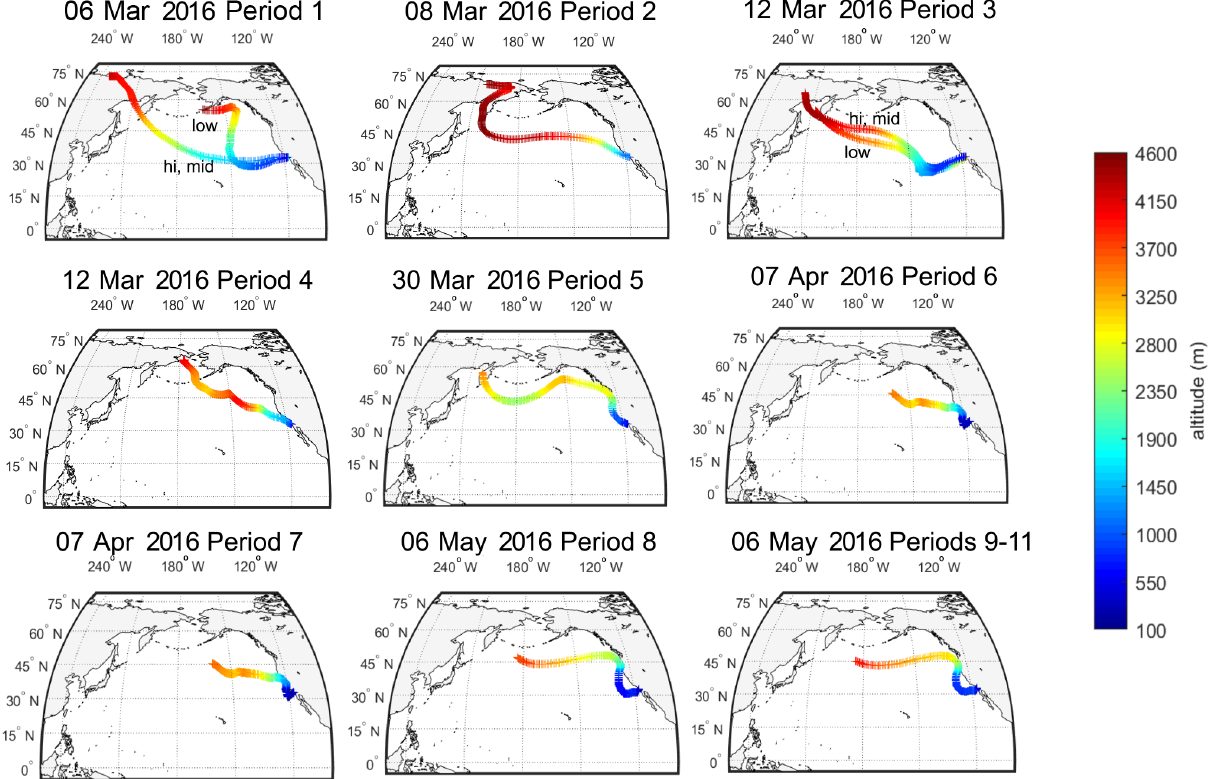
Figure 2. The 10d back trajectories from cloud base, mid-cloud and cloud top during 11 precipitation sampling periods at the SIO pier (32.8662 ◦ N, 117.2544 ◦ W). FLEXPART back trajectories were used to estimate potential source regions of INPs to the clouds during precipitation events. Shown are the particle centroids of back trajectories from three release altitudes within each cloud (see Table S2 for details on altitude selection criteria). If trajectories across the three selected release altitudes differed, they are labeled “hi” for cloud top, “mid” for halfway between base and top, and “low” for cloud bottom. Origins of particles in the 10d simulation are shown to range from 4000m over Russia to 2500–3500m over the Sea of Okhostk, the Bering Sea and the North Pacific. FLEXPART results suggest a dominance of marine particle sources to clouds for sampling periods